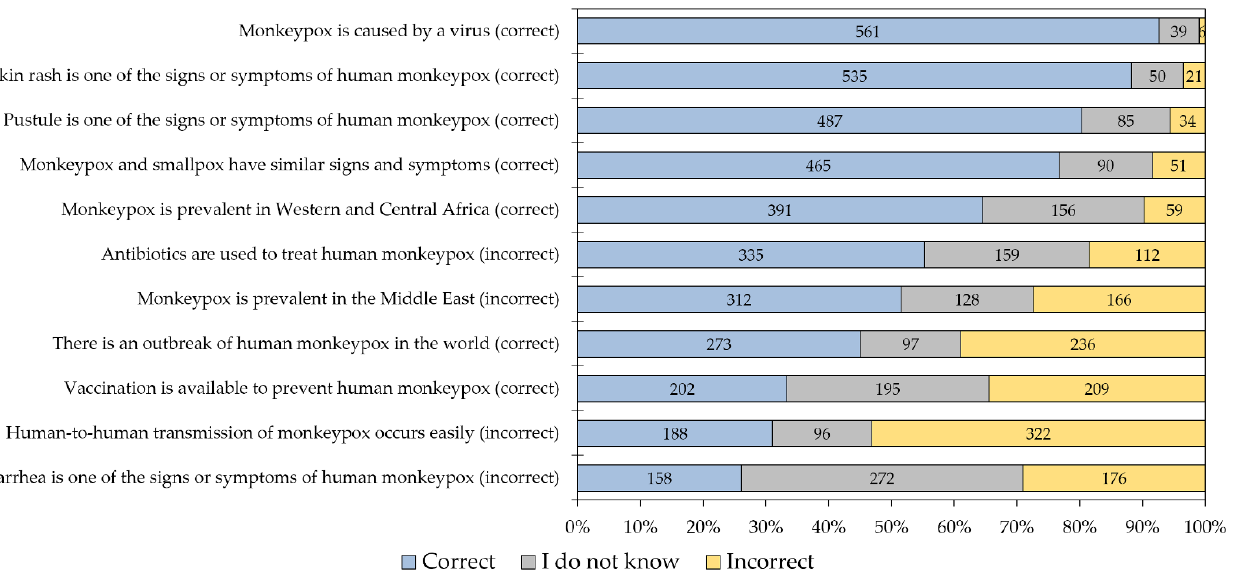
Figure 1. The overall level of human monkeypox knowledge per item among the study respondents.